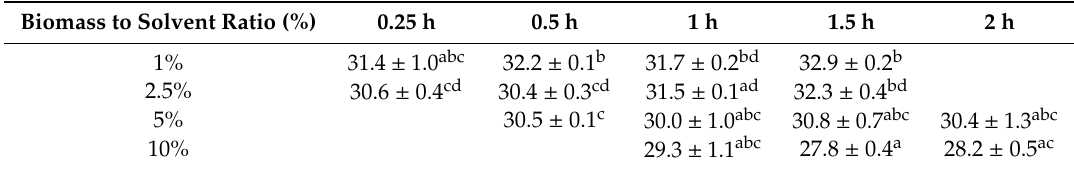
abcd Average values not sharing a common superscript were significantly di ff erent (p <